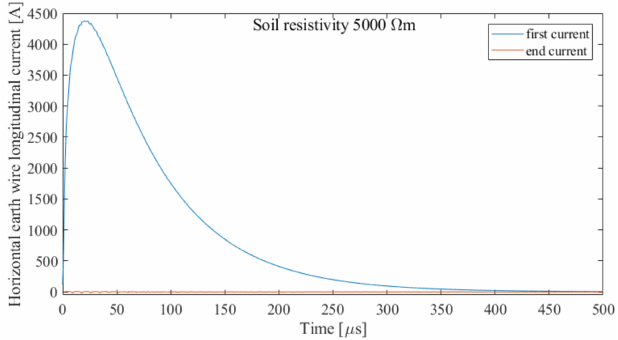
Figure 9. Current time profiles of the copper rope. The distance between the HV/MV station and the MV/LV substation is set equal to 500 m (soil resistivity 5000 Ω ·